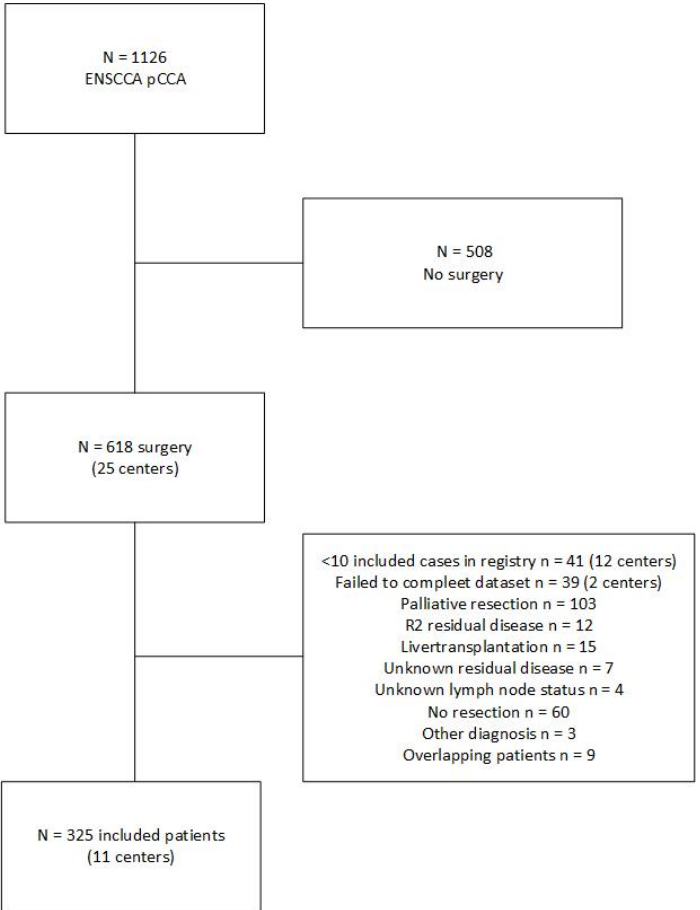
Figure 1. Flow diagram of included patients.